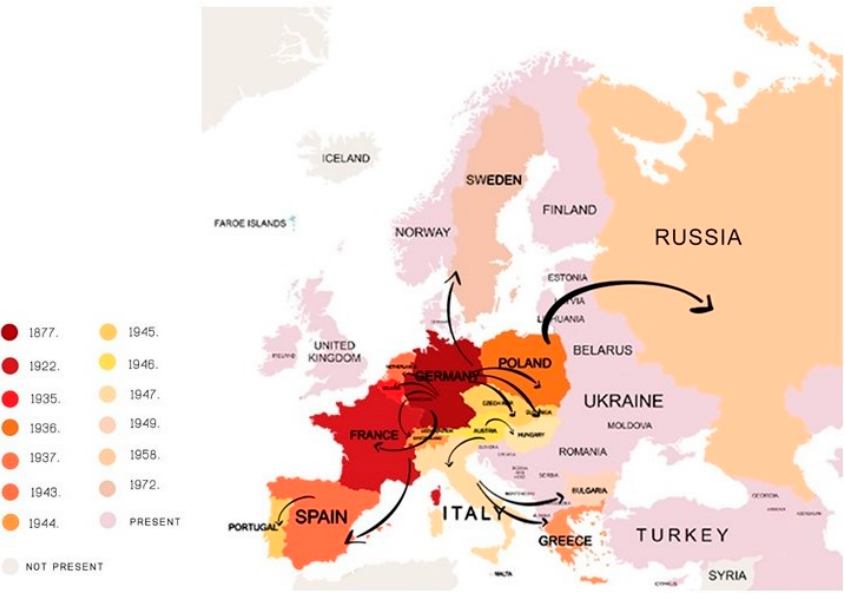
Figure 1. Spread of the Colorado potato beetle over Europe during the 20th century.